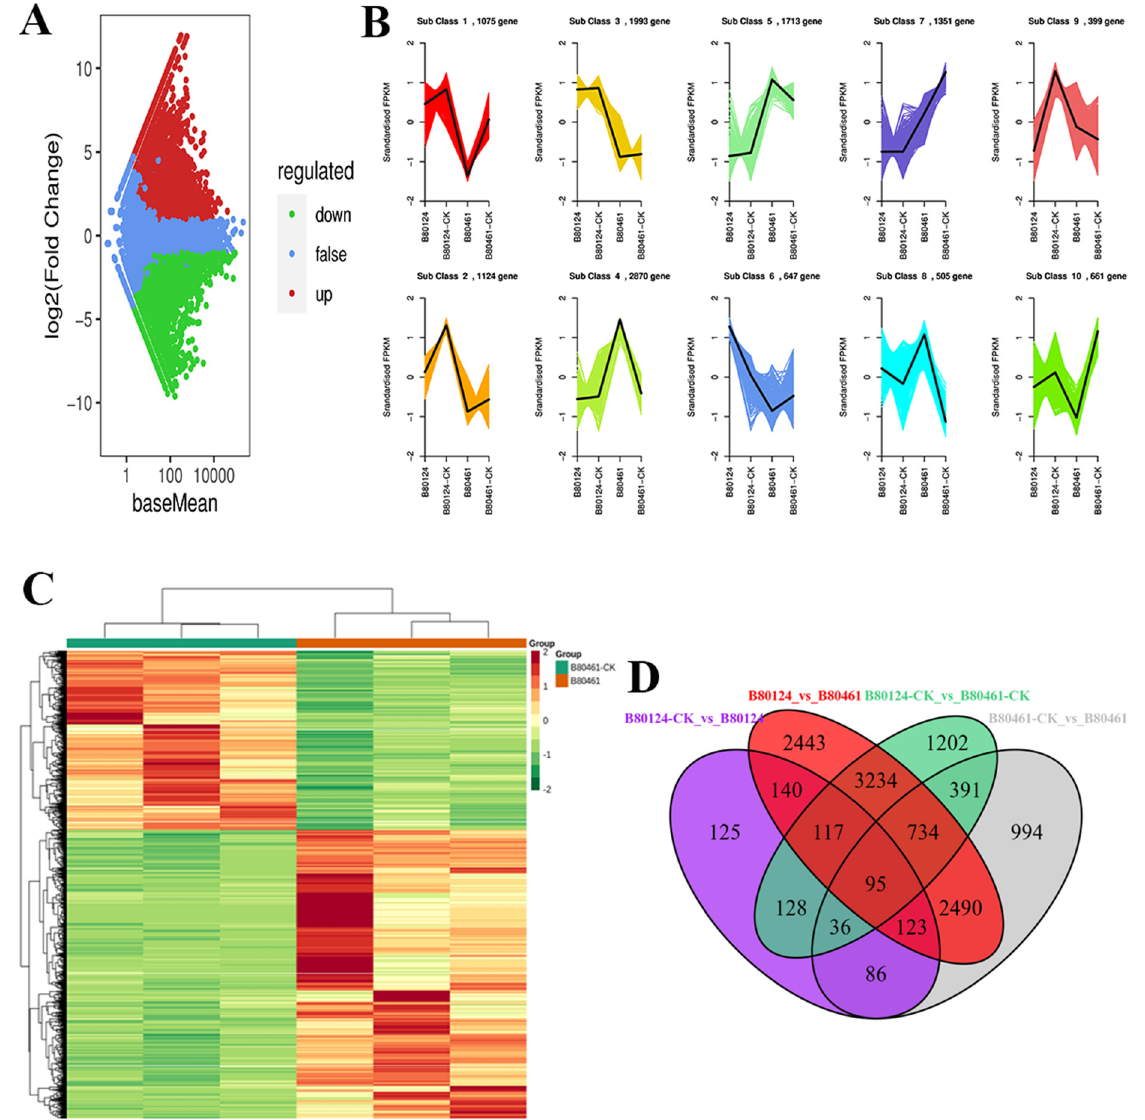
Figure 4. MA analysis showed that after inoculating Brassica rapa with turnip mosaic virus (TuMV), there were more upregulated genes than downregulated genes ( A ). Upregulated and downregulated genes classified through standardized FRKM analysis; the clustering was performed by the k-means values ( B ). All upregulated and downregulated genes among the resistant/susceptible lines are shown in the cluster heat map ( C ). The Venn diagram among different combinations showed the differences in gene changes before and after the inoculation of different materials with TuMV ( D ).